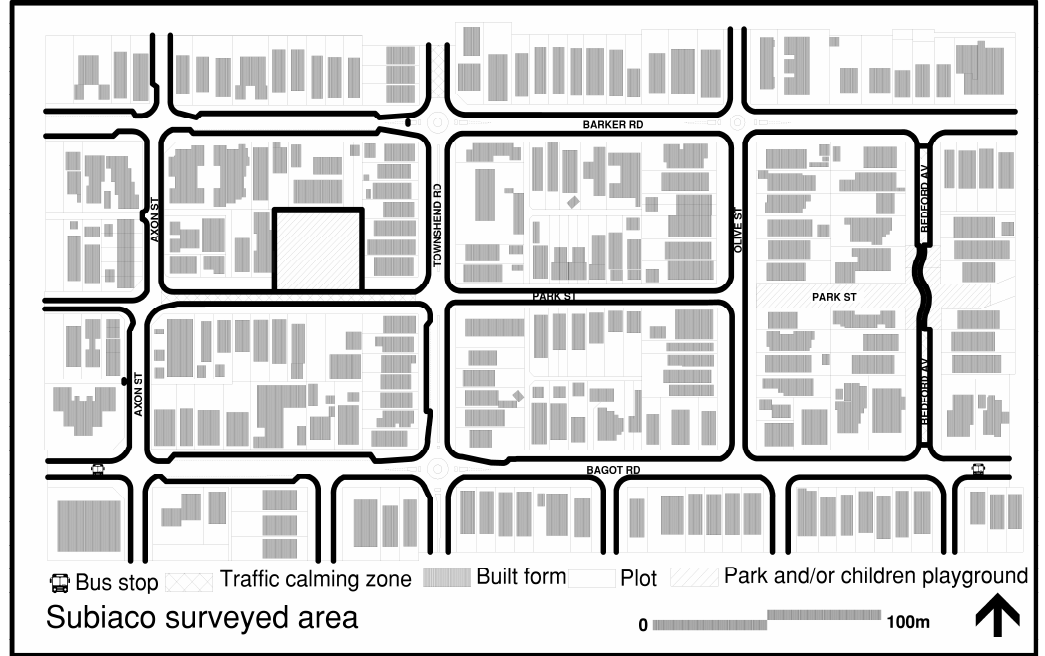
Figure 4. Analysed neighbourhood in Subiaco.